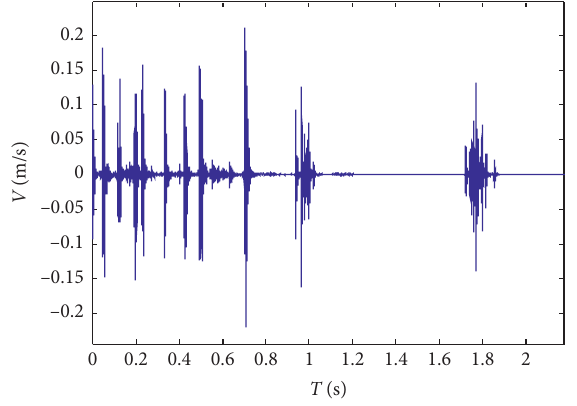
Figure 2: Blasting vibration